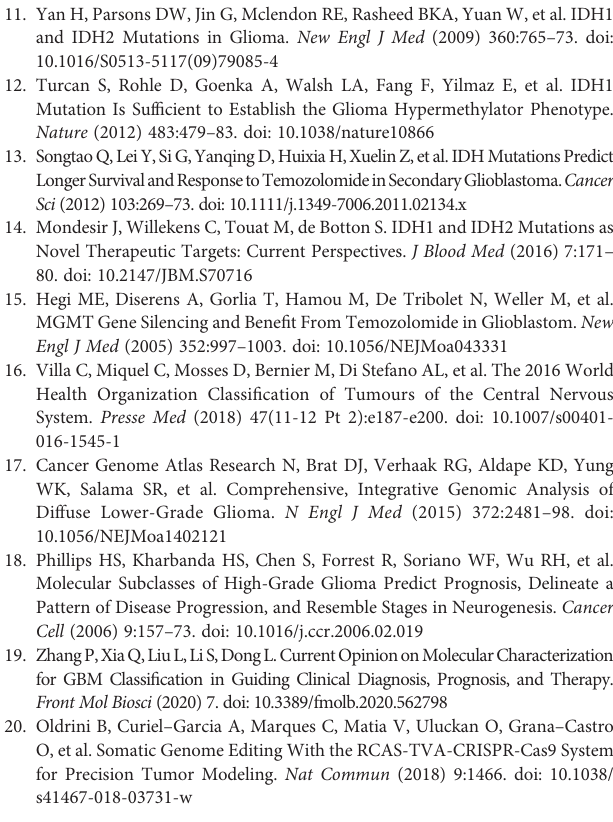
Supplementary Table 1 | Clinical features and normalized count of glioma patients inTCGA and CGGA. Supplementary Table 2 | PTEN mutation list by varscan2 in TCGA glioma patients ( Materials and Methods 2.1 ). Supplementary Table 3 | PTEN-wt subgroup-speci fi c DEGs. Supplementary Table 4 | PTEN-mut subgroup-speci fi c DEGs. Supplementary Table 5 | 44 OPR-DEGs in the PTEN-wt subgroup. Supplementary Table 6 | DEGs between high risk patients and low risk patients in TCGA PTEN-wt subgroup. Supplementary Table 7 | 11 OPR-DEGs in the PTEN-mut